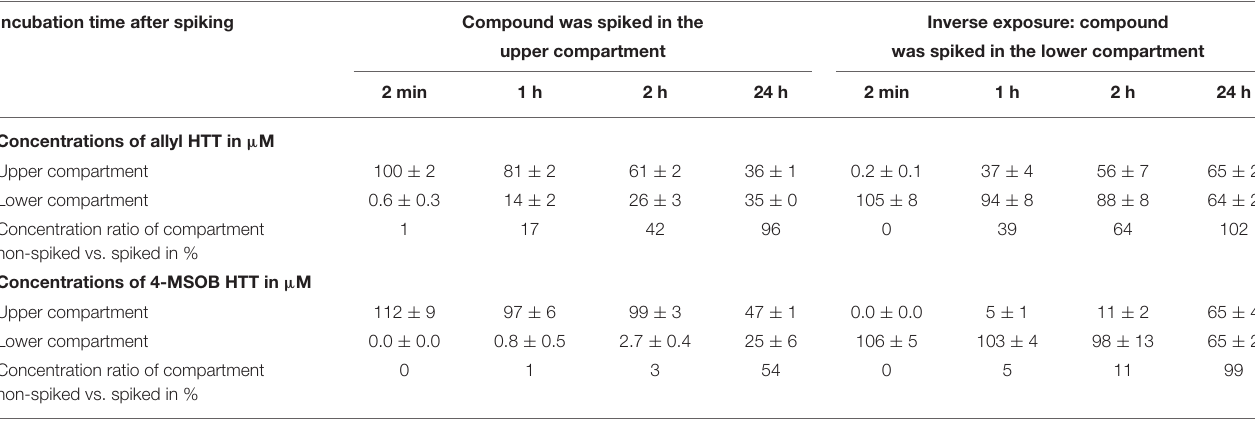
TABLE 3 | Transport of 3-allyl-4-hydroxythiazolidine-2-thione (allyl HTT) and 4-hydroxy-3-(4-(methylsulfinyl)butyl)thiazolidine-2-thione (4-MSOB HTT) through an in vitro model of the intestinal barrier by spiking the compound in the upper compartment (transwell insert) or lower compartment (well) to a closed Caco-2 cell layer and sampling from both compartments after different incubation times ( n = 6 biological replicates, results shown as mean ± SD). Incubation time after